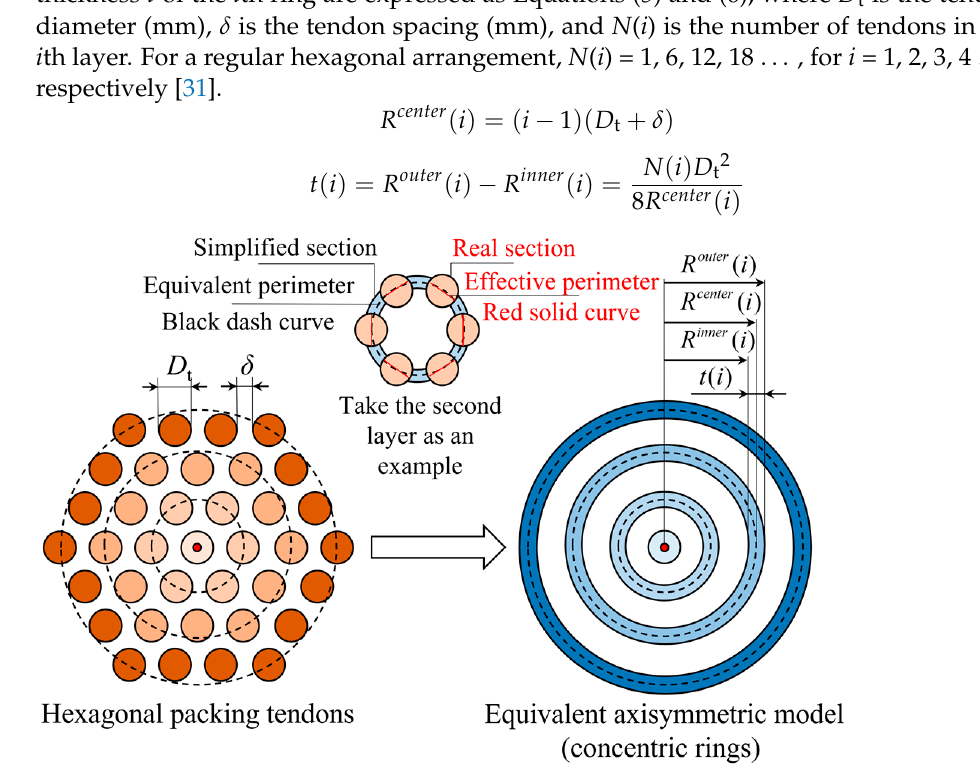
Figure 5. Simplification of the parallel-tendon cable.